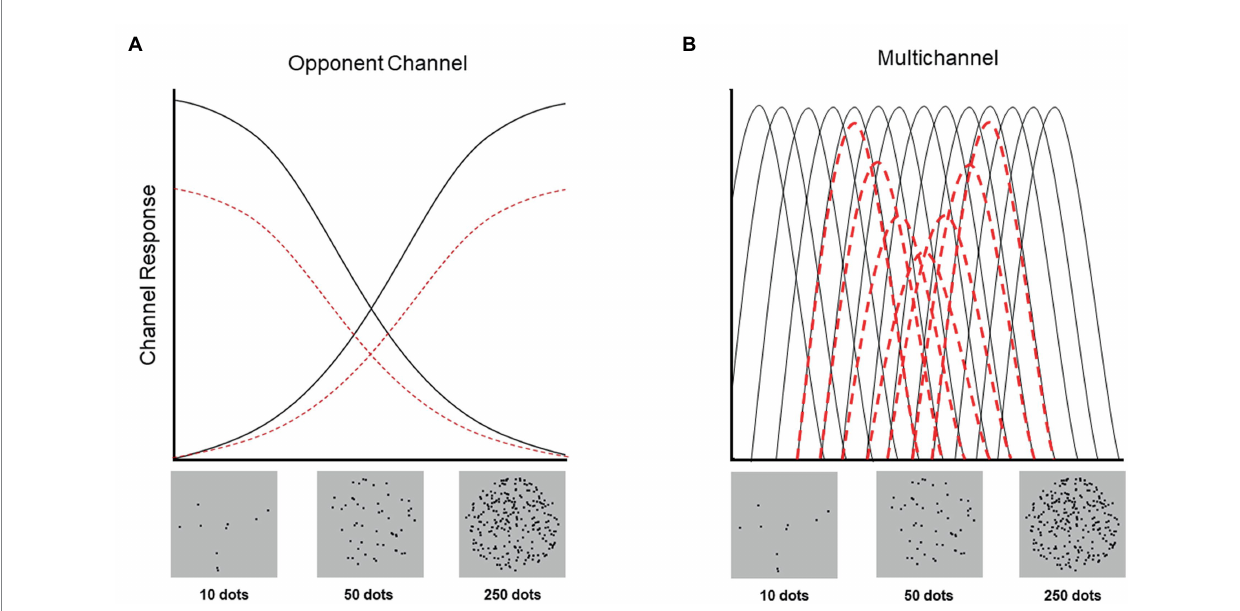
FIGURE 1 Schematic depiction of adaption to an intermediate value (i.e., 50 dots) in opponent channel and multichannel coding systems where the numerical values represented by this system is hypothesized to range from 10 to 250 (Anobile et al., 2016). The y-axis refers to the intensity of each channel’s response and the x-axis refers to the numerical value of the stimulus presented (without adaptation [black] and with adaptation to 50 [red]). (A) In an opponent channel system, adaptation to 50 does not result in a perceptual aftereffect because both channels (small and large numerosities) are adapted equally. In other words, although both small and large channels respond less strongly following adaptation (red dashed lines), no perceptual aftereffects occur because stimuli are represented by the difference in response between the two channels, which remains constant (depicted by the location of the intersection of the two solid black lines and two dashed red lines, on the horizontal axis). (B) By contrast, in a multichannel system, adaptation to 50 (or any other value) results in repulsive perceptual aftereffects, with the strongest effects occurring around the adapted value (depicted by the relative difference in height between the solid black and dashed red lines). For example, if viewing 40 dots normally (i.e., in the absence of adaptation) results in channels tuned to 40 responding at their maximum intensity, and channels tuned to 30 and 50 responding at 50% their maximum intensity, then following adaptation to 50 dots, viewing 40 dots may result in channels tuned to 50 responding only at 25% their maximum intensity. Because of this reduction, 40 dots will be perceived more similar to 35 dots.